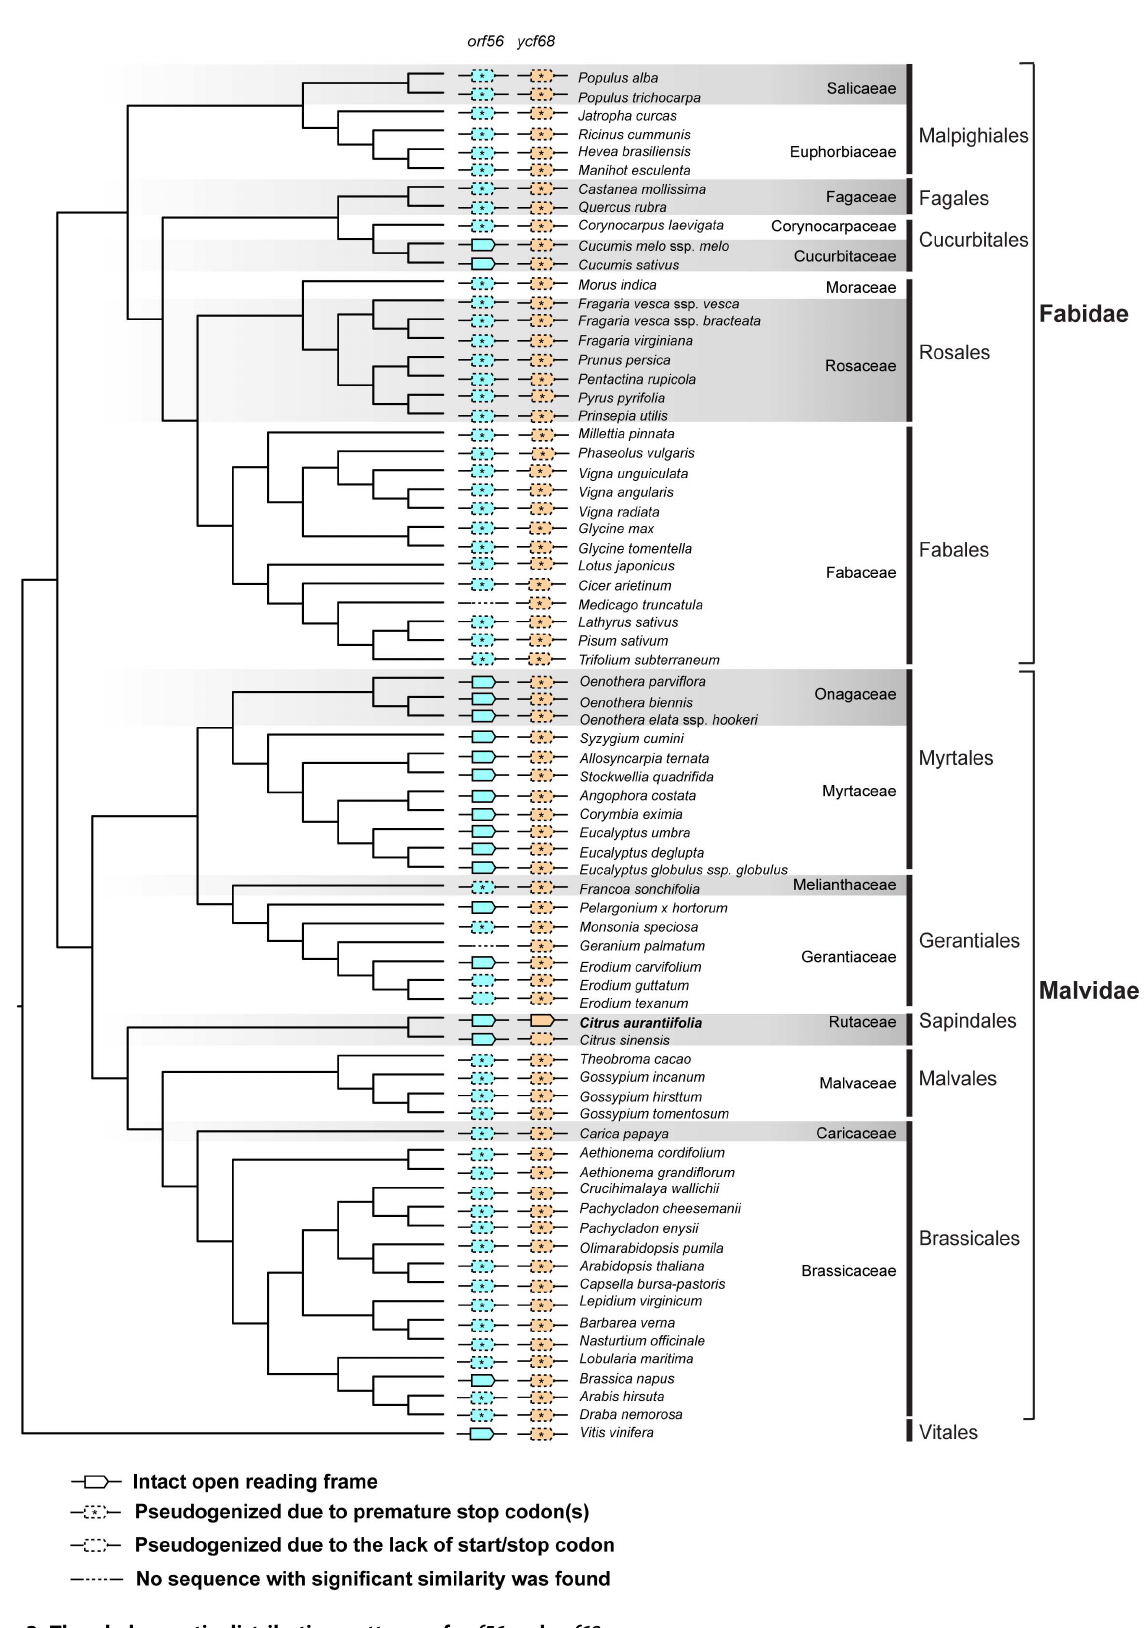
Figure 3. The phylogenetic distribution patterns of orf56 and ycf68 .